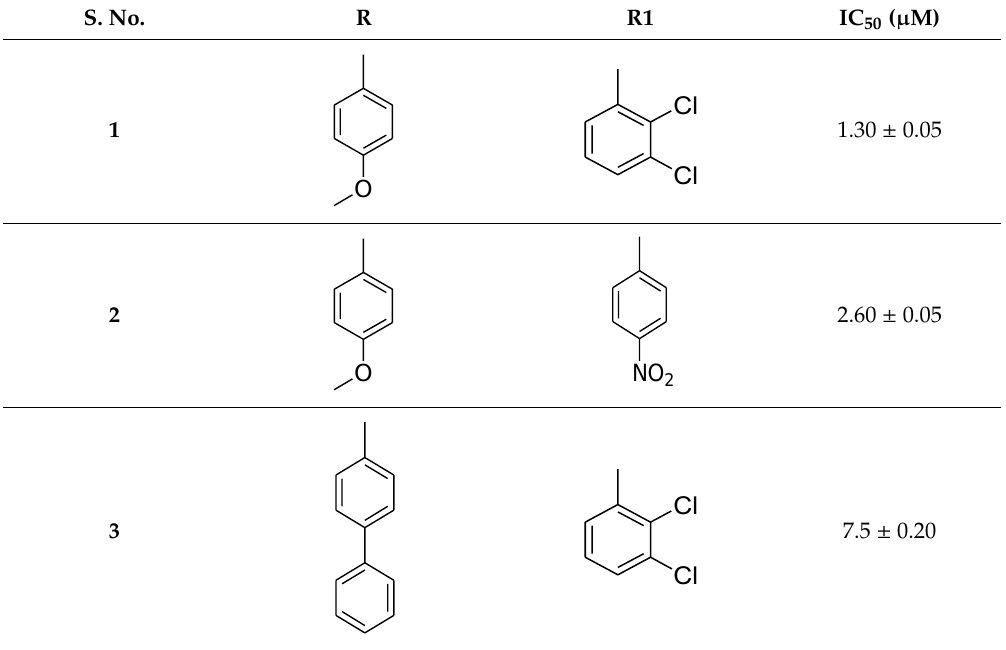
Table 1. Structure of triazinoindole-based thiosemicarbazide analogs and their α -glucosidase